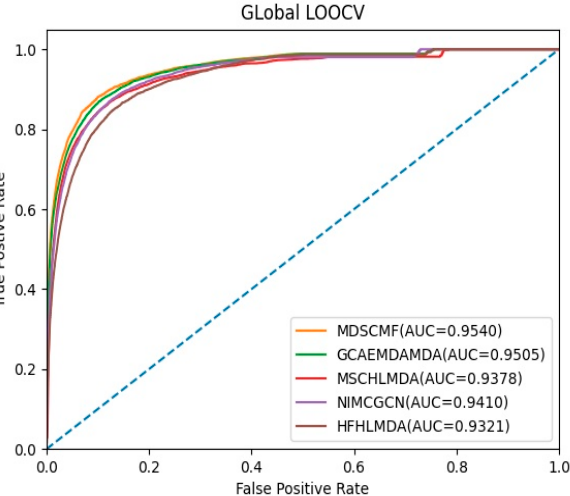
Figure 2. AUC of global LOOCV compared with those of GCAEMDA, MSCHLMDA, NIMCGCN, and HFHLMDA.